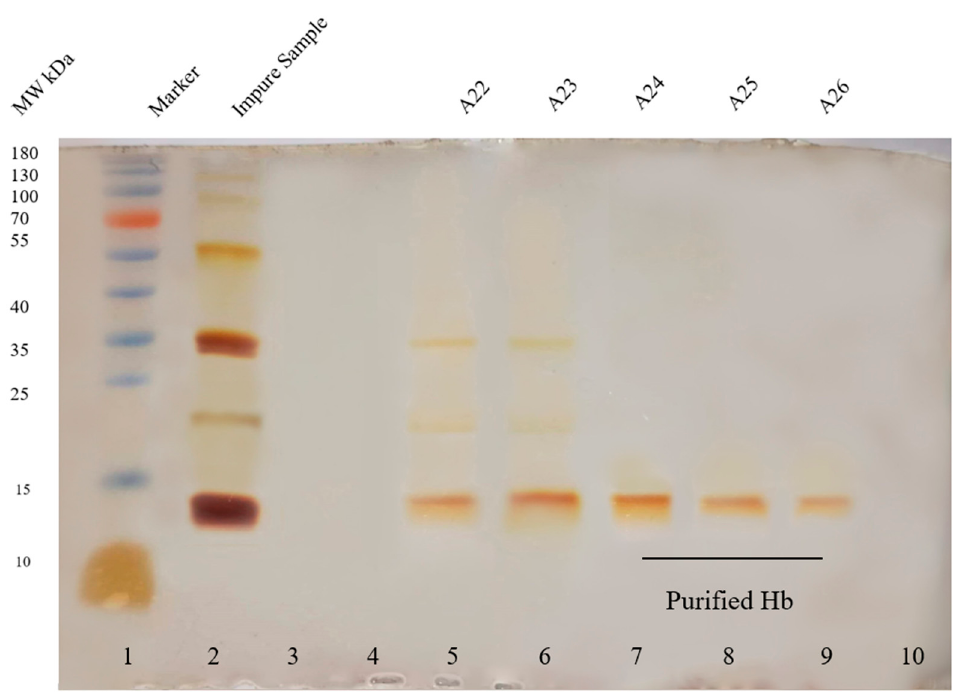
Figure A6. Color image of SDS PAGE complete gel.